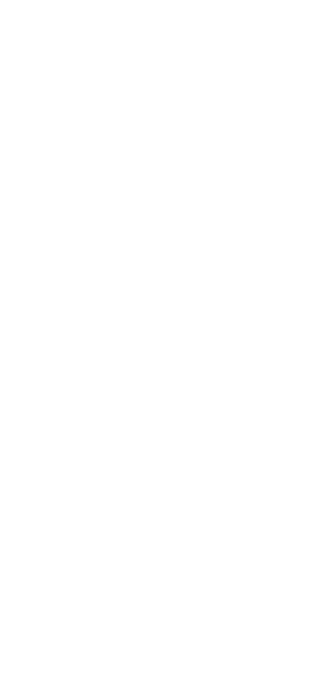
FIGURE 5 | S. epidermidis induces Toll-like receptor (TLR) expression in mouse retina. C57BL/6 mice eyes (n = 4 eyes each time point) were infected with S. epidermidis (10 7 cfu/eye) by intravitreal injections, and the retina tissue was harvested at the indicated time points. Eyes with PBS injection harvested at 72 h p.i. were used as control. Infected and control (C) retinal tissues were used for RNA isolation and subjected to qPCR for various Toll-like receptors ( Tlr 2, 4, 6, 9). The data are presented as fold changes in comparison with uninfected controls. Statistical analysis was performed using ANOVA with Dunnett ’ s multiple comparison test, (*) p<0.05 (**) p<0.01 (****)